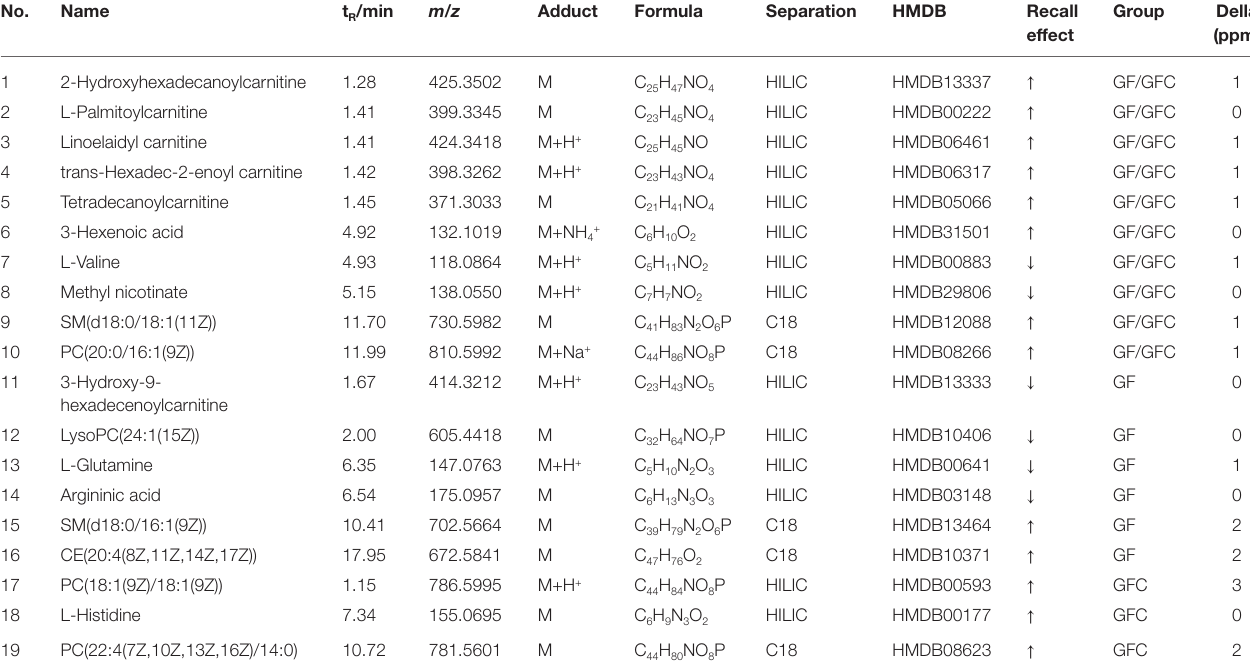
TABLE 2 | Putative biomarkers in rats treat with GF and GFC with HILIC/C18-UHPLC/MS. No.